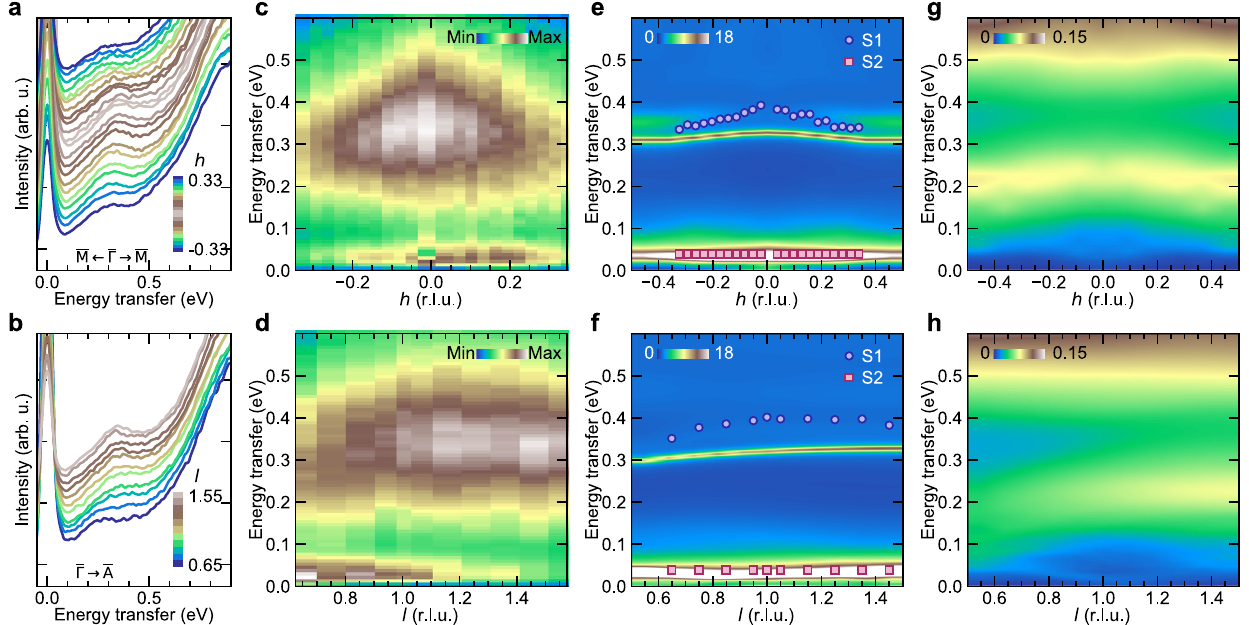
Fig. 3 | Dispersion of the fl at band Stoner excitations in the E − q -space in Co 3 Sn 2 S 2 . RIXS line spectra for momentum transfer parallel to ( a ) Γ M direction from h = − 0.33 to h =0.33 at l =1.25 and B , Γ A direction from l =0.65 to l =1.55 at h =0.05. c , d RIXSintensitymapscorrespondingtothelinespectrashownin( a , b ), with fi tted elastic and background contributions subtracted. e , f Calculated vertex corrected dynamic spin structure factor S ( q , ω ) intensity maps along the RIXS